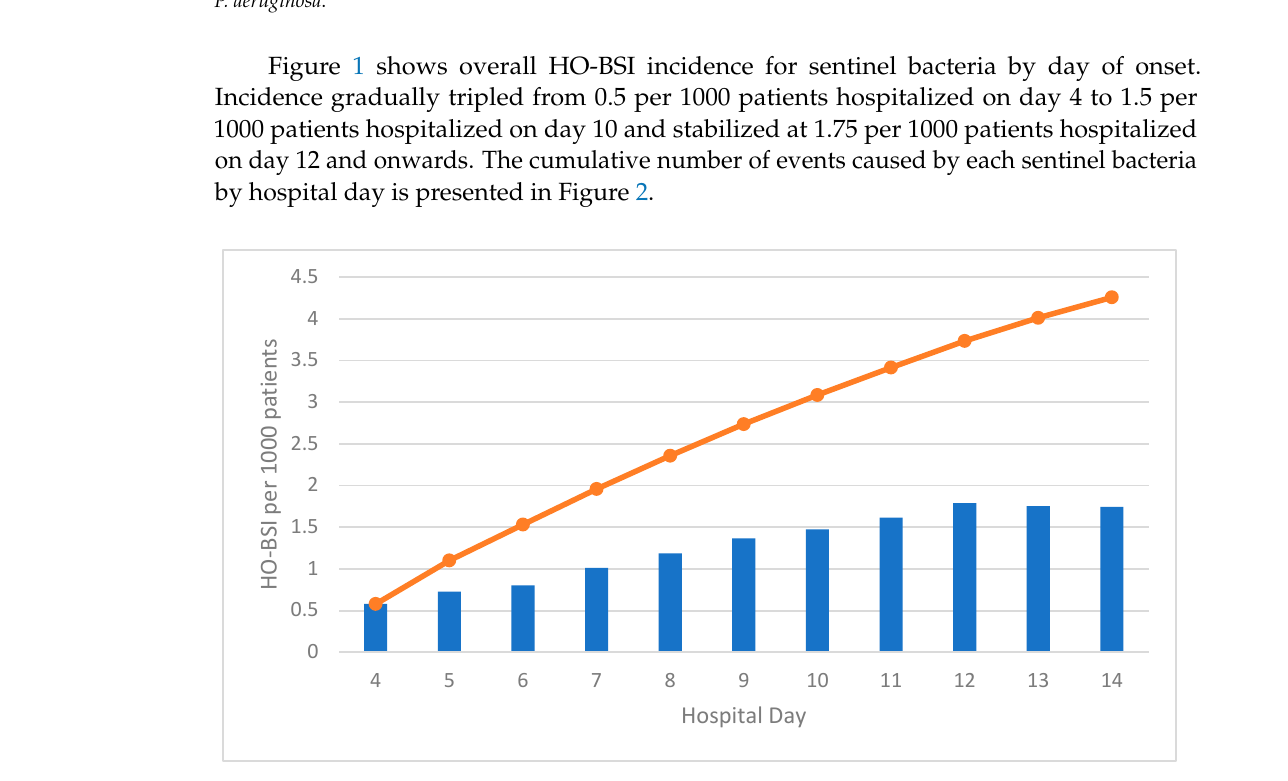
Figure 1. Incidence (bars) and cumulative incidence (line) of hospital-onset bloodstream infections (HO-BSIs) caused by sentinel bacteria, by hospital day of onset.